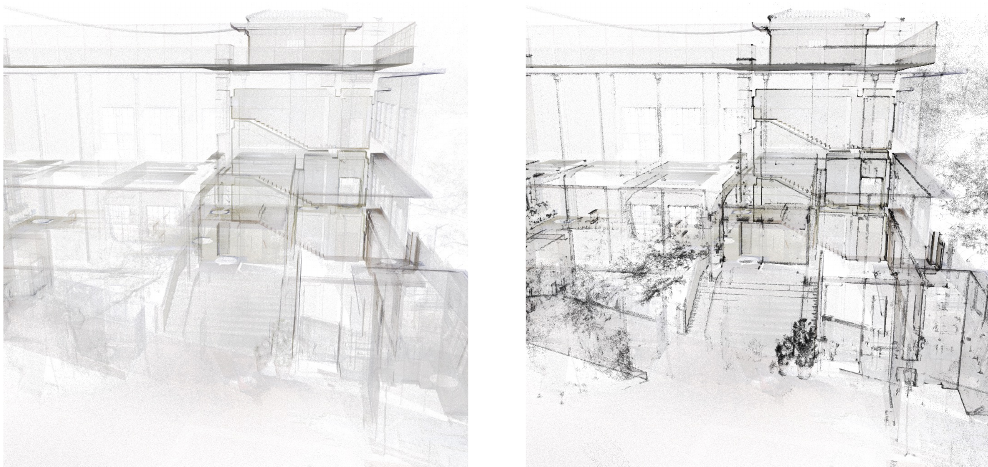
Figure 1. Transparent visualizations of a 3D scanned campus building. The left image shows the ordinary case without the edge-highlighting effect. The right image is created by incorporating our edge-highlighting effect. The campus building is at Kyoto Women’s University in Kyoto City,